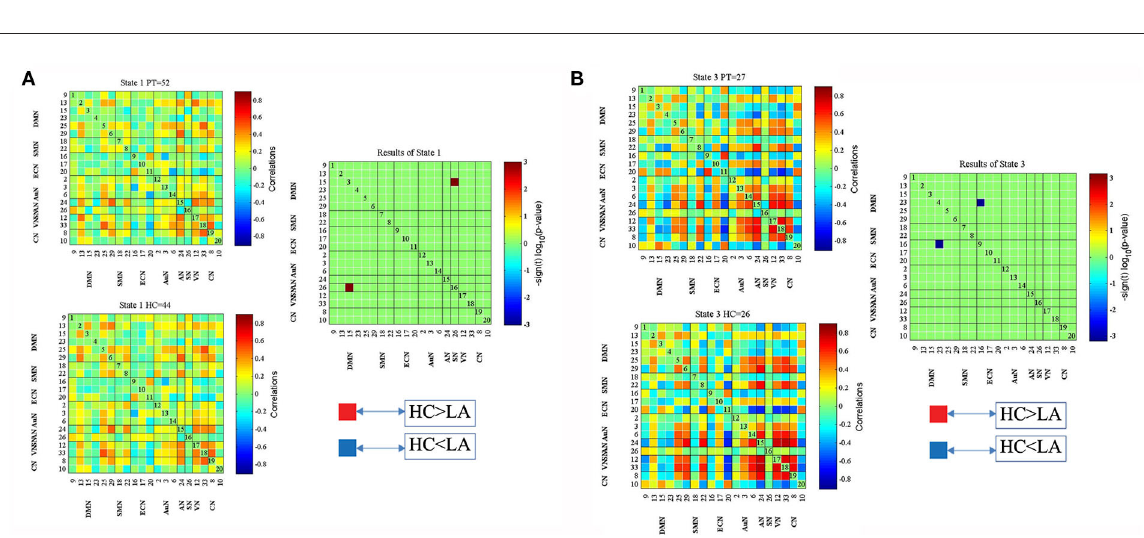
LA and emphasize the importance of detecting LA for dFNC temporal properties. Further studies are required to confirm whether aberrant functional segregation and the number of state transitions can act as potential biomarkers for